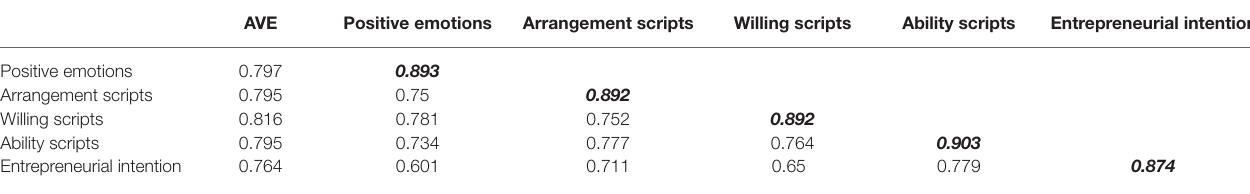
TABLE 6 | Fornell and Larcker criterion. AVE Positive emotions Arrangement scripts